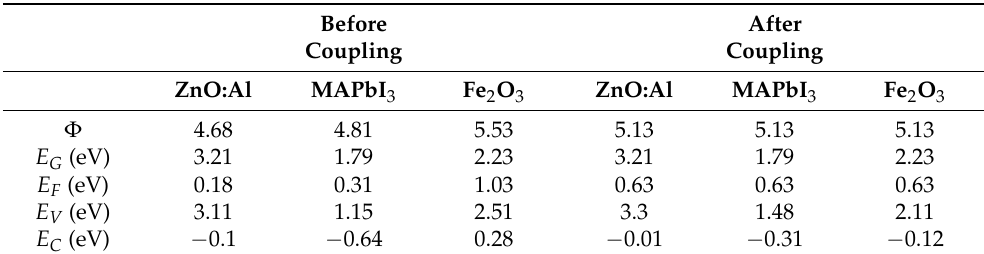
Table 1. Computed electronic properties for freestanding ZnO:Al, MAPbI 3 and Fe 2 O 3 before and after coupling. All values are calculated vs. NHE.